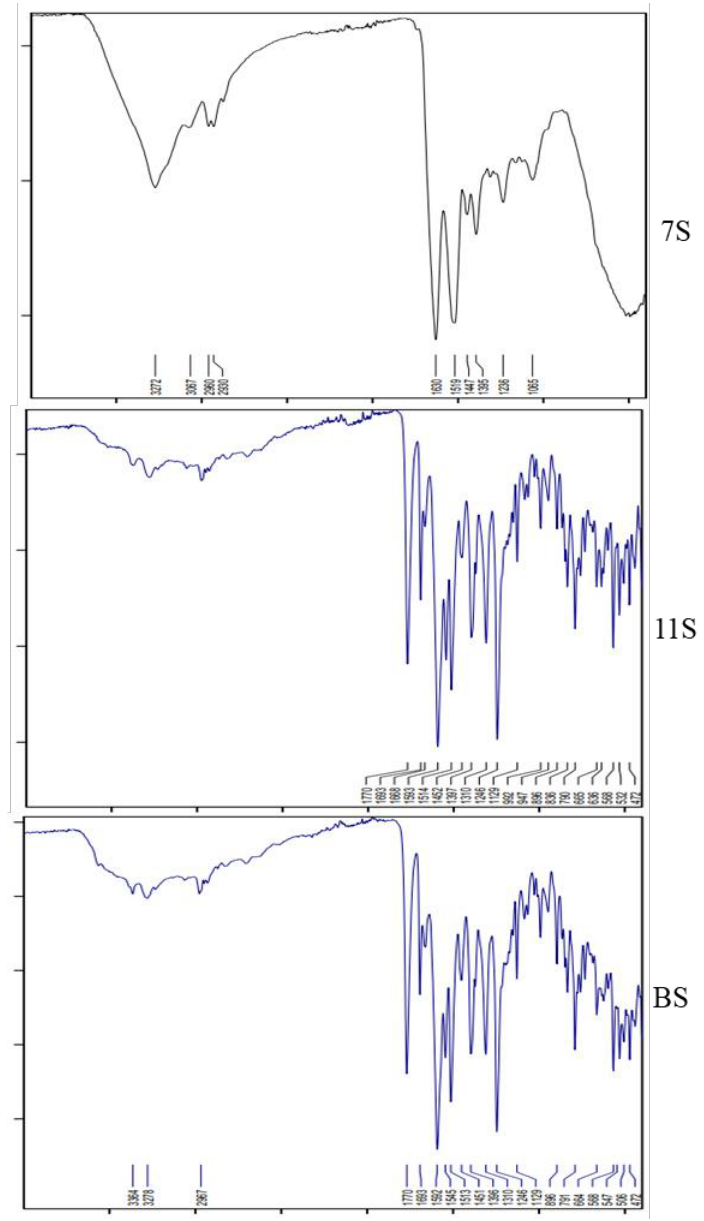
Figure 3. FT-IR spectra of lupine seed protein: 7S and 11S globulins and BS.